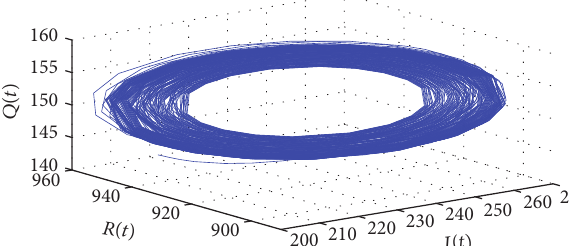
= 3.574 and 𝜏 = 2.25 ∈ (0, 𝜏 ) . 1 2 20